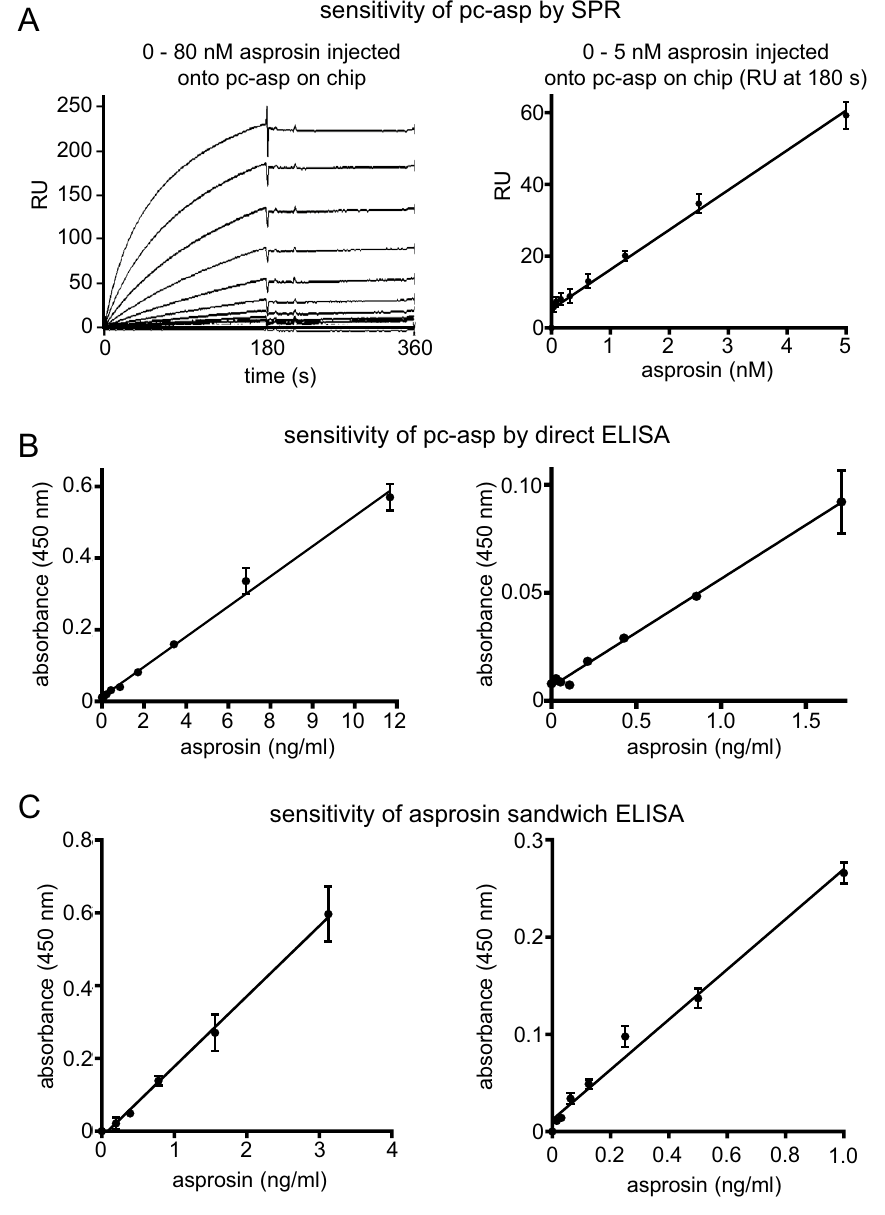
Figure 2. Establishment of assays for sensitive asprosin detection. ( A ) Testing of pc-asp sensitivity using surface plasmon resonance (SPR). (left) Sensorgrams showing detection of recombinant asprosin injected at 0–80 nM (0–2960 ng/ml) onto pc-asp immobilized to the sensor chip. (right) Robust and linear response of asprosin injected at 0–5 nM (0–185 ng/ml) onto pc-asp immobilized on chip. ( B) Asprosin detection by direct ELISA using pc-asp as detector antibody (1:2000 dilution, 0.5 µg/ml). Robust and linear ELISA signal response of immobilized recombinant asprosin. ( C) Sensitive detection of asprosin in solution by sandwich ELISA. Pc-asp was immobilized as capture antibody (3 μg/ml) and mab anti-asprosin (AdipoGen Life Sciences Inc., San Diego, USA) was used as detector antibody (1:2000 dilution, 0.5 µg/ml). Data points represent mean ± SD from duplicates. Data were analyzed using Graphpad Prism version